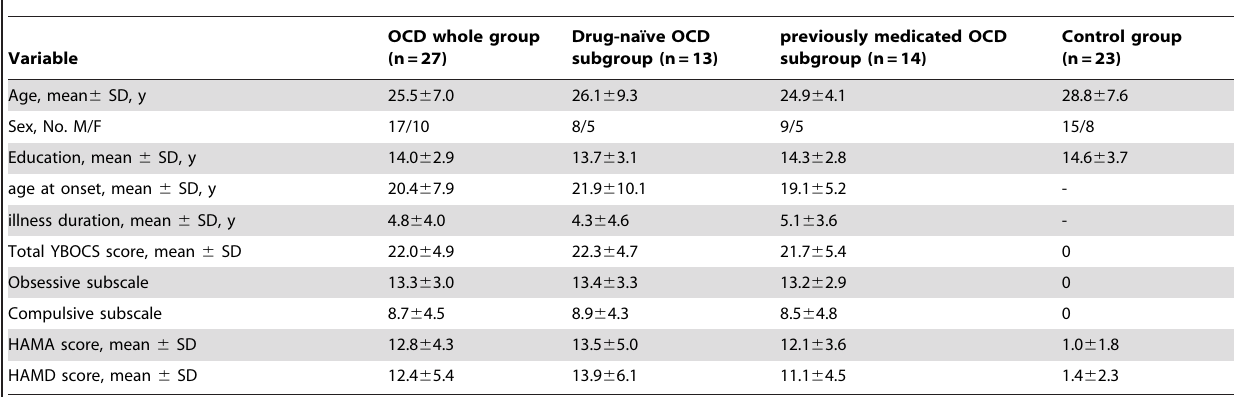
Table 1. The Demographics and Clinical Characteristics of the Baseline